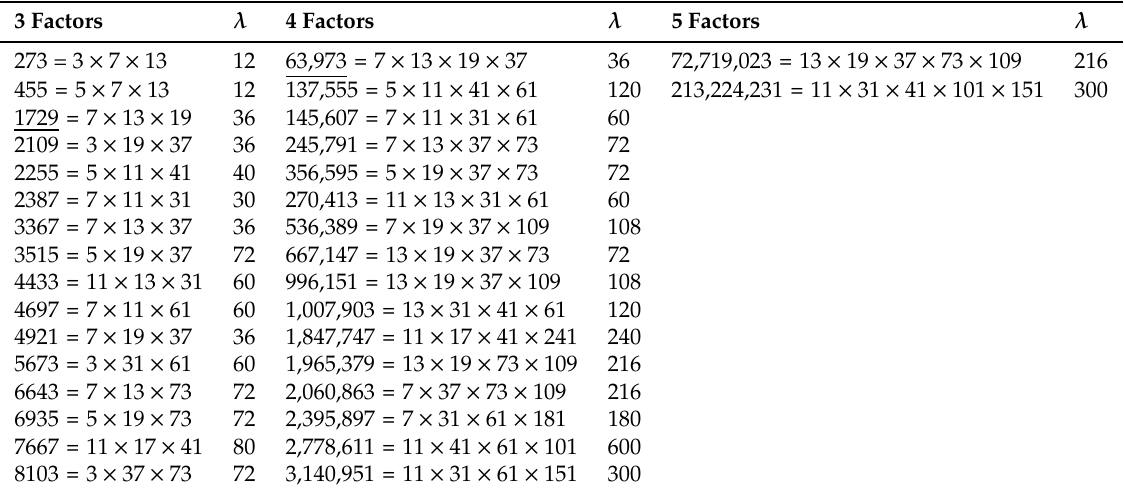
Table 2. Maximally idempotent integers with 3, 4 and 5 factors.